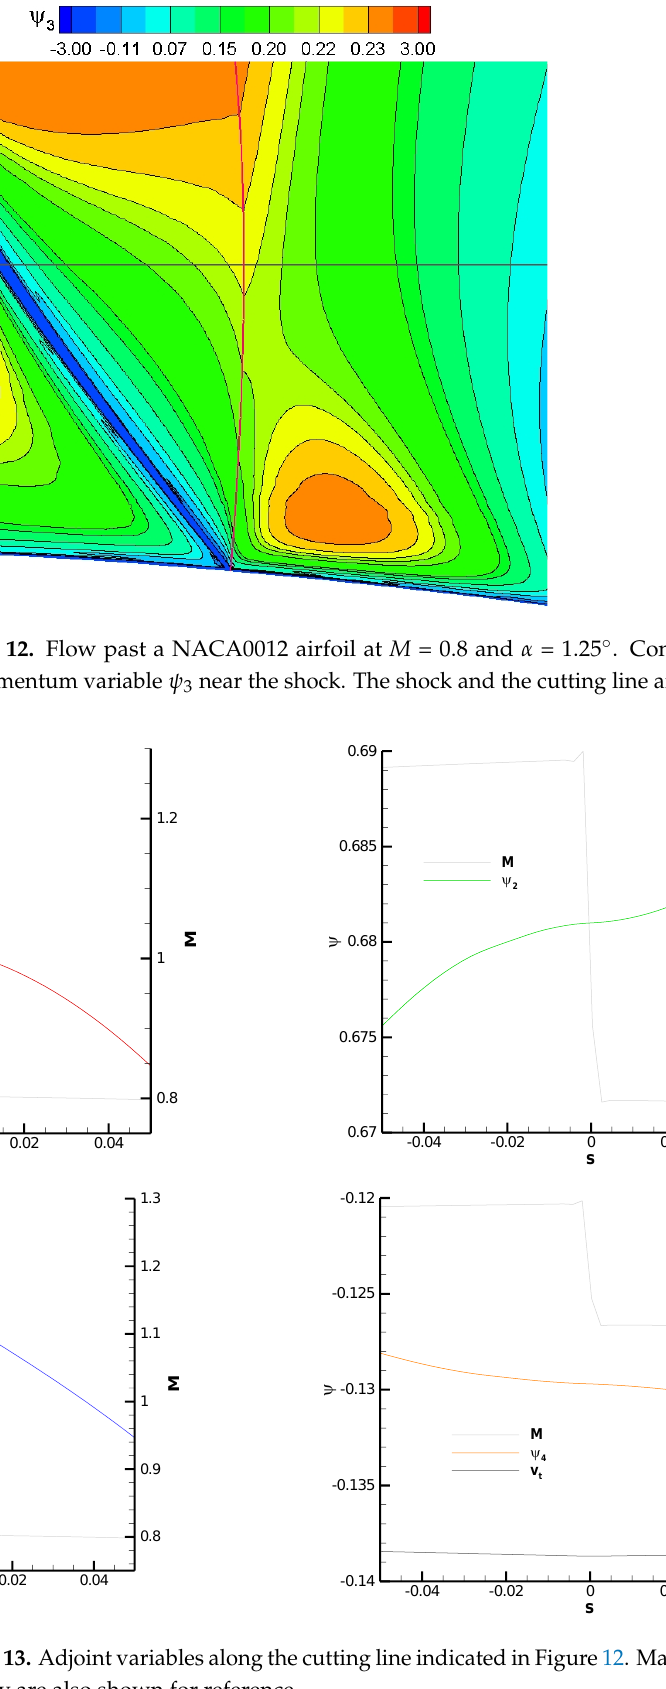
Figure 11. Flow past a NACA0012 airfoil at M = 0.8 and α = 1.25°. Contour lines for the x − momentum variable ψ 2 ( a ) and y − momentum variable ψ 3 ( b ). The shock position is indicated for reference.